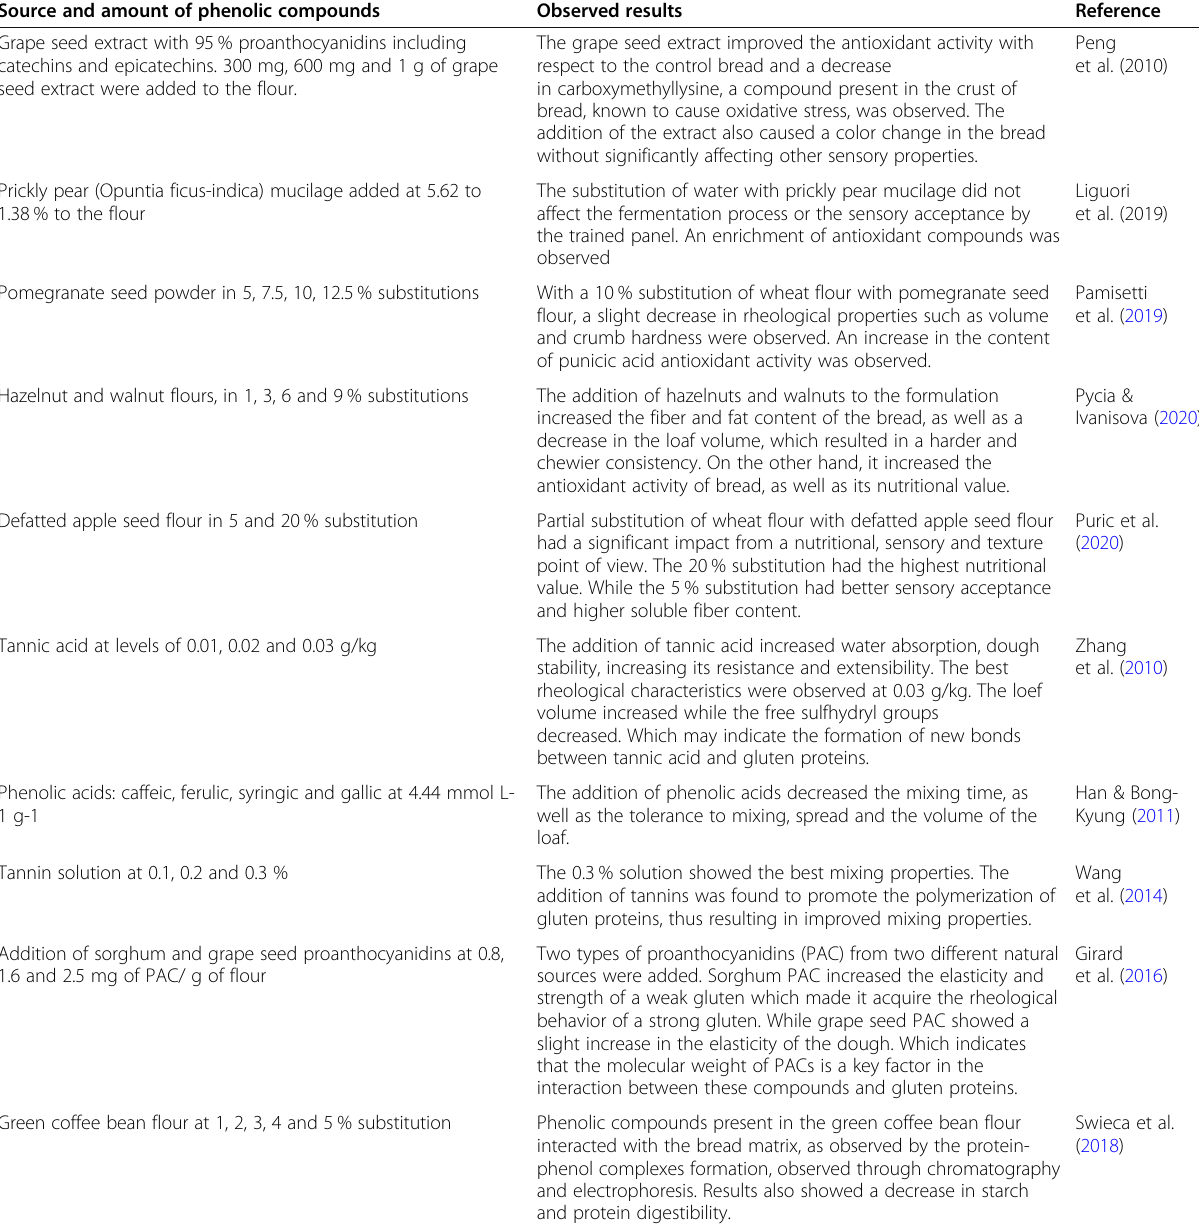
Table 1 Effect of the addition of byproducts on the sensorial, rheological, antioxidant and health beneficial properties of wheat bread Source and amount of phenolic compounds Observed results